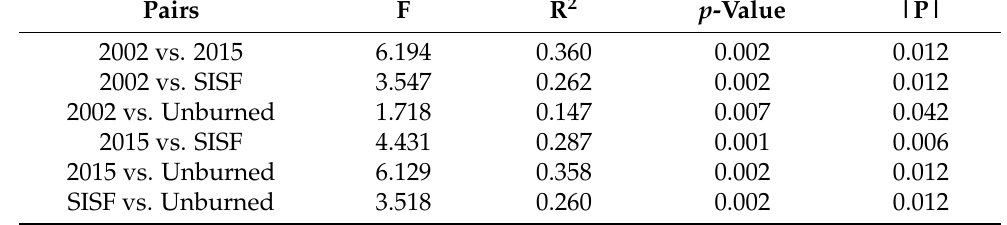
Table 2. Pairwise comparison of assemblage compositions between sampling locations. PER- MANOVA tests are df 3, 21 = 4.19, p -value < 0.01.